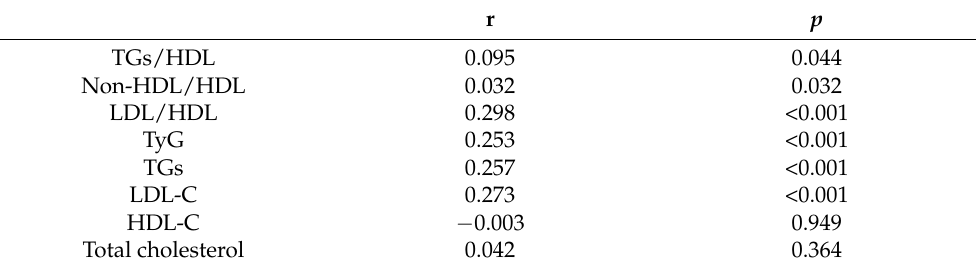
Table 4. Pearson correlations between the lipid ratio and